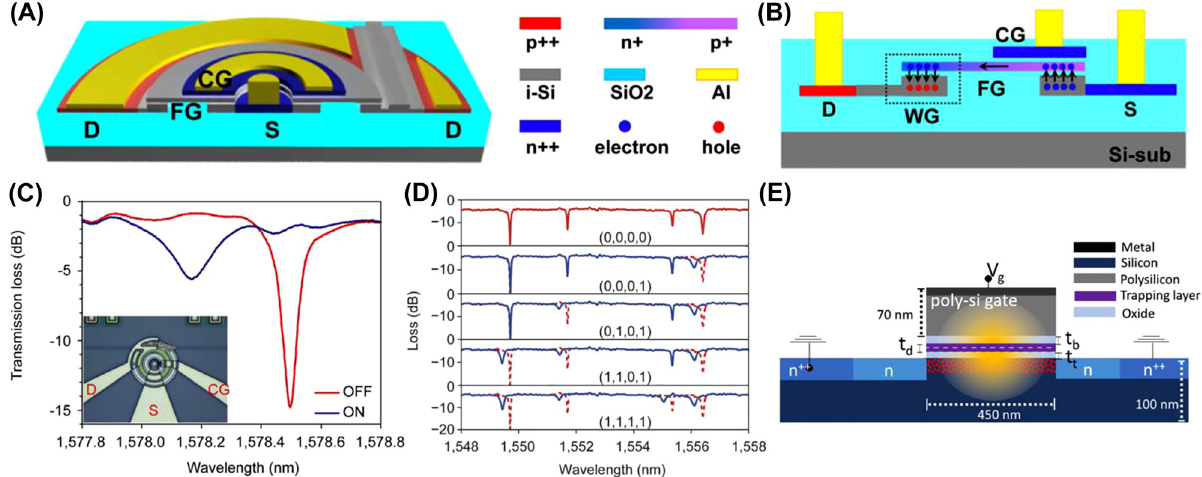
Figure 8: Optical memories based on trapped charge effects. (A – D) A CMOS-compatible, electrically programable, and optically readable memory device [103]. (A) Tilted and (B) cross-sectional schematic of the photonic memory cell. The black arrows show the fl ow of charge carriers during programanderase operations. (C) Transmission spectrawhen the memorycell is “ ON ” and “ OFF ” . There is a 325 pmblue-shift in the resonant wavelength when the device is turned “ ON ” . (D) Transmission spectra of the microring memory array. Each microring can be individually programed. (E) Cross-sectional schematic of the SAHAS structure